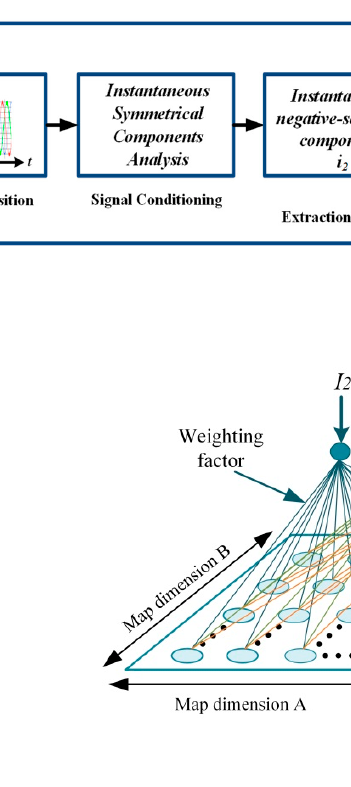
Figure 8. Procedure of stator and rotor windings diagnosis using ISCA and Kohonen network (SOM): ( a ) flow chart of the signal processing; ( b ) scheme of the SOM network with the analysed inputs (in our case SOM size is 10 × 10).